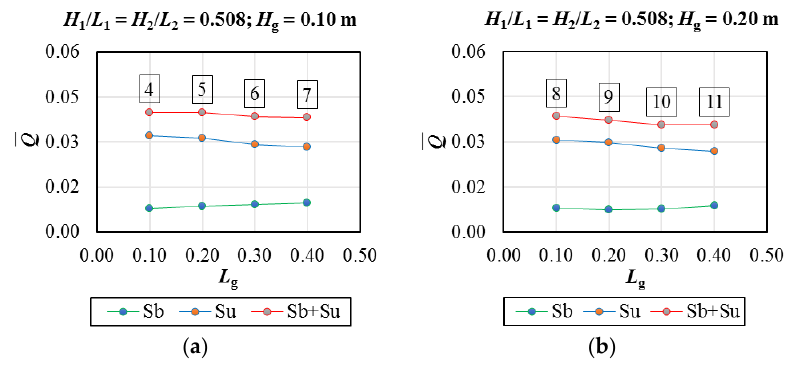
̅ × L Figure 18. Behavior of Q ̅ × L g for: ( a ) cases 4, 5, 6 and 7 and ( b ) 8, 9, 10 and 11. Figure 18. Behavior of Q ̅ × L g for: ( a ) cases 4, 5, 6 and 7 and ( b ) 8, 9, 10 and 11. g for: ( a ) cases 4, 5, 6 and 7 and ( b ) 8, 9, 10 and 11. Figure 18. Behavior of Q × L g for: ( a ) cases 4, 5, 6 and 7 and ( b ) 8, 9, 10 and 11. Figure 18. Behavior of Q